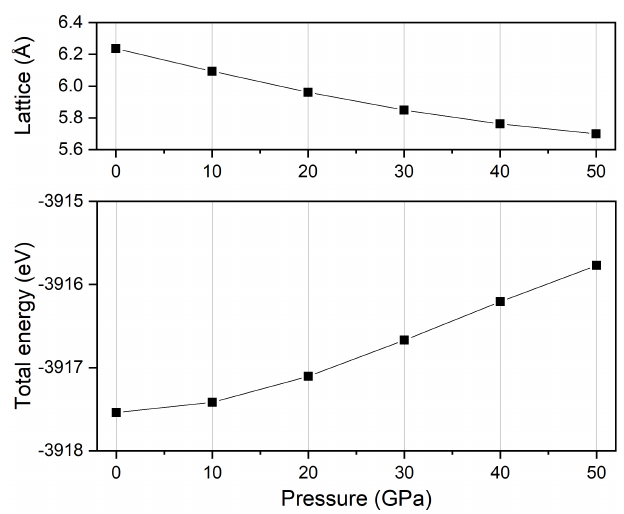
Figure 2. The calculated equilibrium lattice and total energy of Ti 2 MnAl compound at different